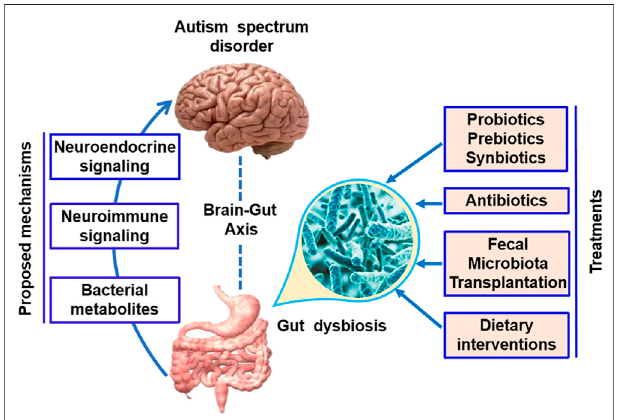
FIGURE 1 | Microbial-based therapeutic interventions in ASD. The gut microbiotahasbeenfoundtoaffectbrainfunctionthroughtheneuroendocrine signaling, neuroimmune signaling, and bacterial metabolites. Potential microbial-based therapeutic interventions in ASD include prebiotic/ probiotic/synbiotic, antibiotics, fecal microbiota transplantation, and dietary interventions.